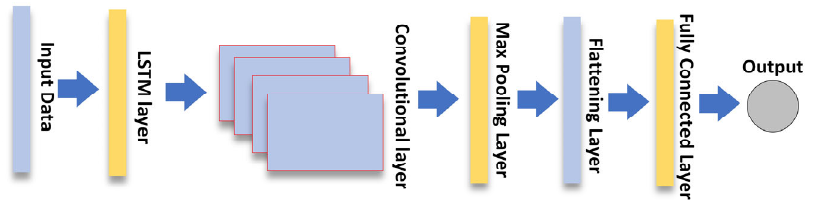
Figure 4. The structure of LSTM ‐ CNN model.